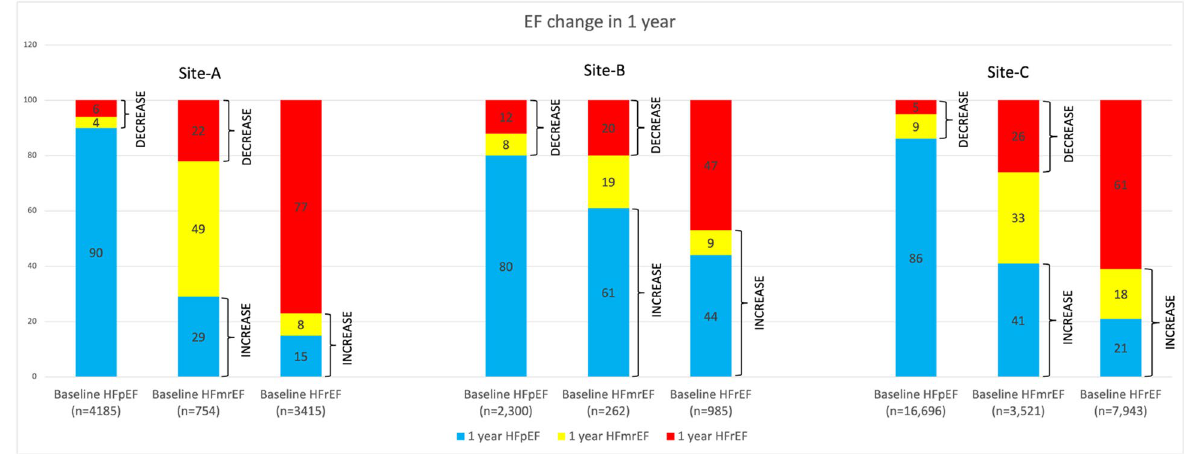
Figure 5. EF changes in 1 year among HF subphenotypes. Each bar segment shows the proportion (%) of patients with changes with stable EFs in each category as